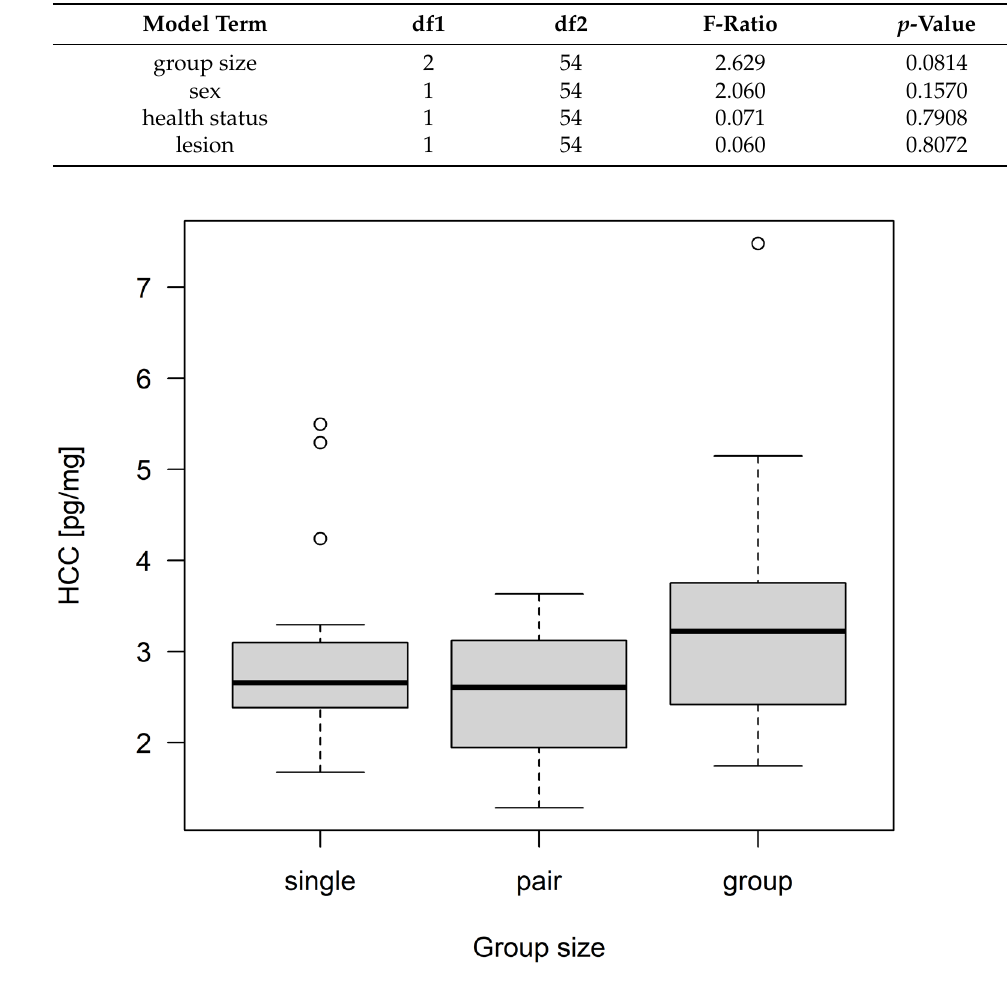
Figure 2. Hair corticosterone concentration (HCC) of kits in different housing treatments (single housing, in pairs or groups of three does). The HCC values [pg/mg] are shown as box plots with minimum, lower quantile, median, upper quantile, maximum, and outliers (N = 60 kits).